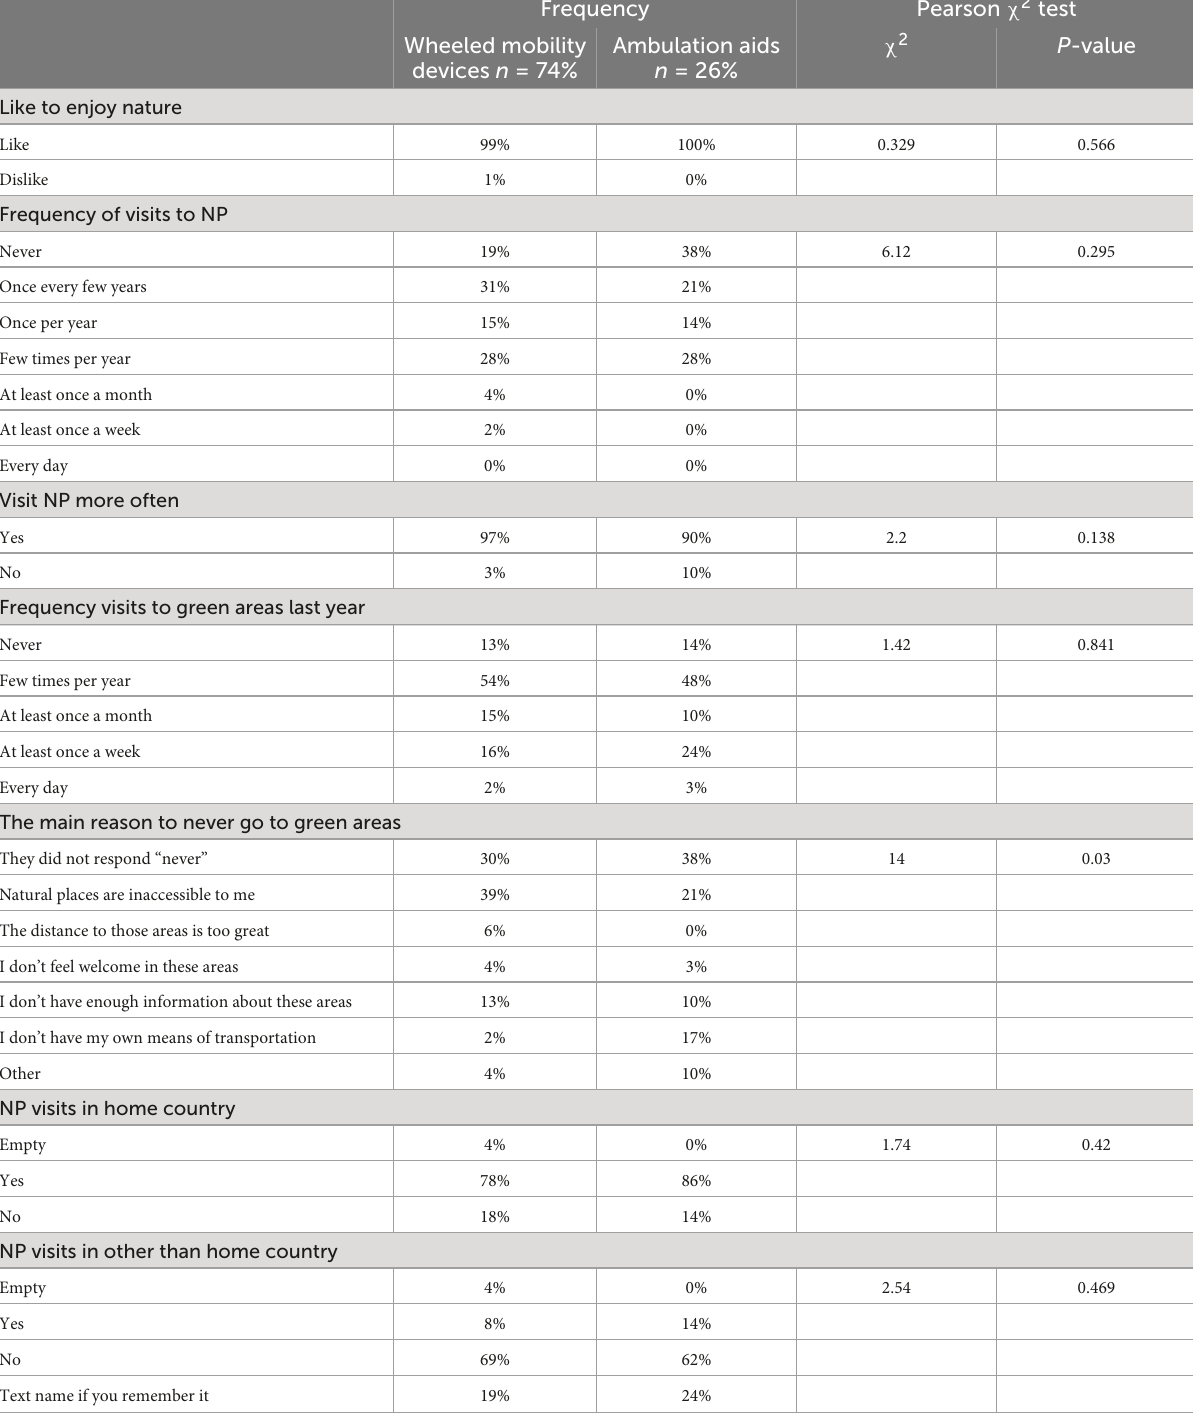
TABLE 4 Results of Pearson’s chi-square test of the first part of questions in section II on public nature